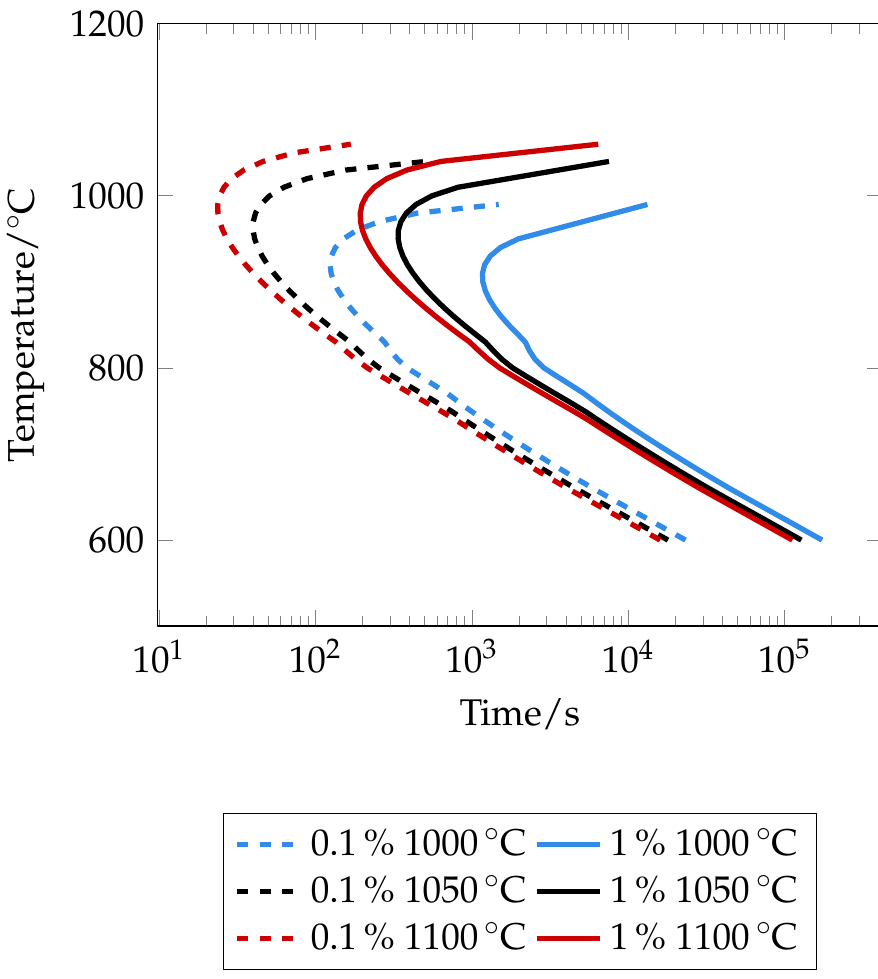
Figure 10. TTT 0.1% and 1% amount transformed (stainless steel mode: Austenitic) calculated by transformed (gen- Figure 9. TTT 1 % amount Figure 10. TTT 0.1 % and 1 % amount transfor- JMatPro ® used for FEM. Transformation data of M 23 C 6 is eral steel and stainless steel mode for Carbides) men (stainless steel mode: Austenitic) calcu- lated by JMatPro R used for FEM. Transforma- (cid:13) tion data of M C is shown. 23 6